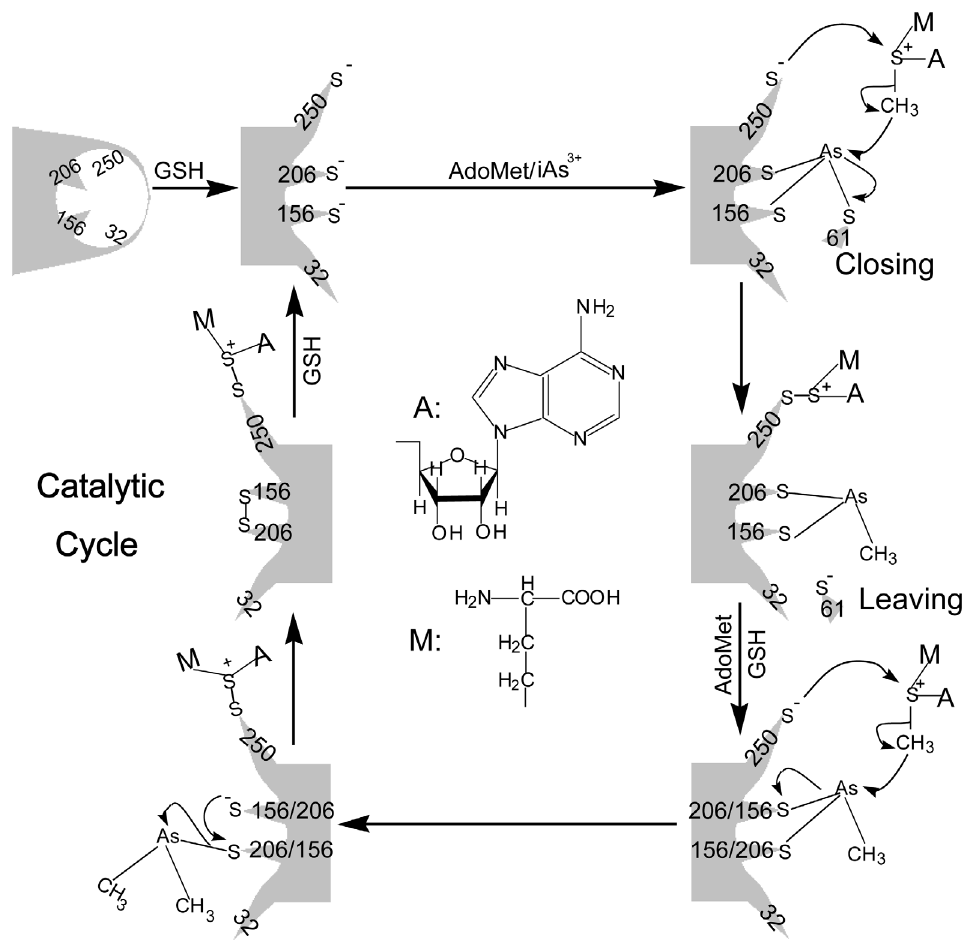
Figure 9. Possible model for the mechanism of hAS3MT-catalyzed iAs 3 + methylation. A and M respectively represent the structure of Adenosyl and CH 2 CH 2 CH(NH 2 )COOH.